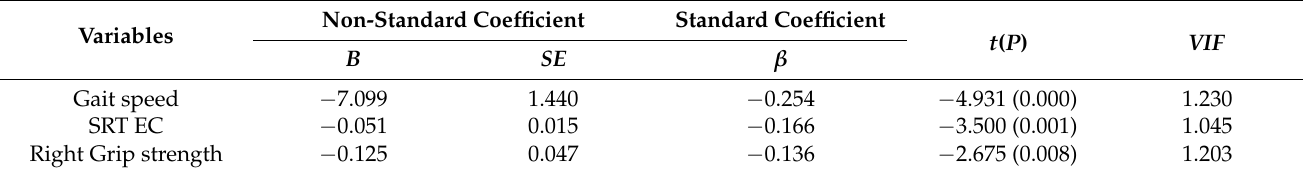
Table 4. Association between fall risk factors and depression ( n =